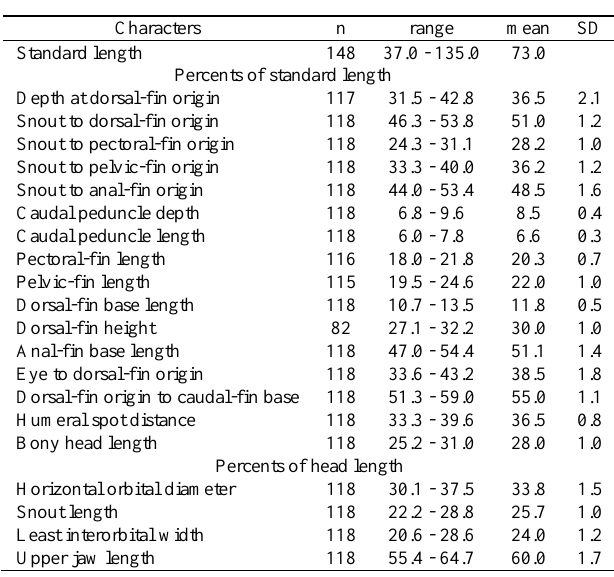
Table 10 . Morphometrics of Charax michaeli . Specimens